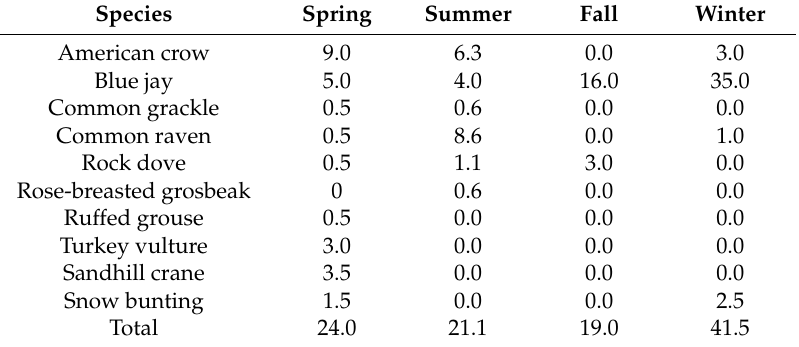
Table 2. Mean number of seasonal camera capture events of birds per 10 km of railway for one year (2015 to 2016). Species Spring Summer Fall Winter American crow